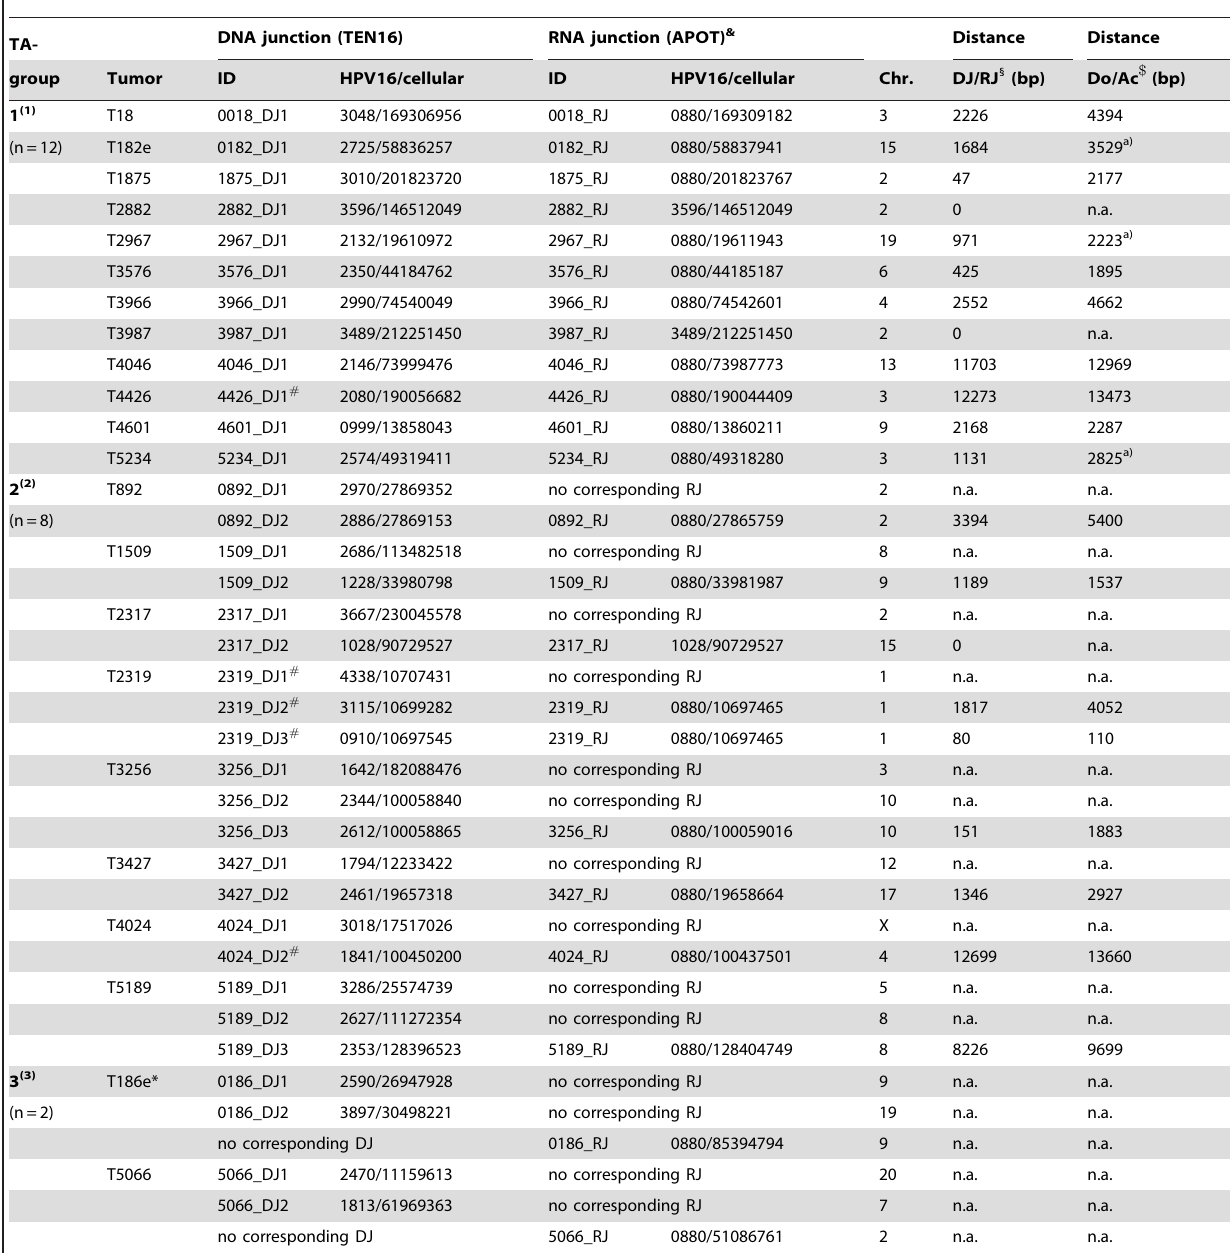
Table 2. Comparison of HPV16-cellular DNA junctions and RNA junctions.